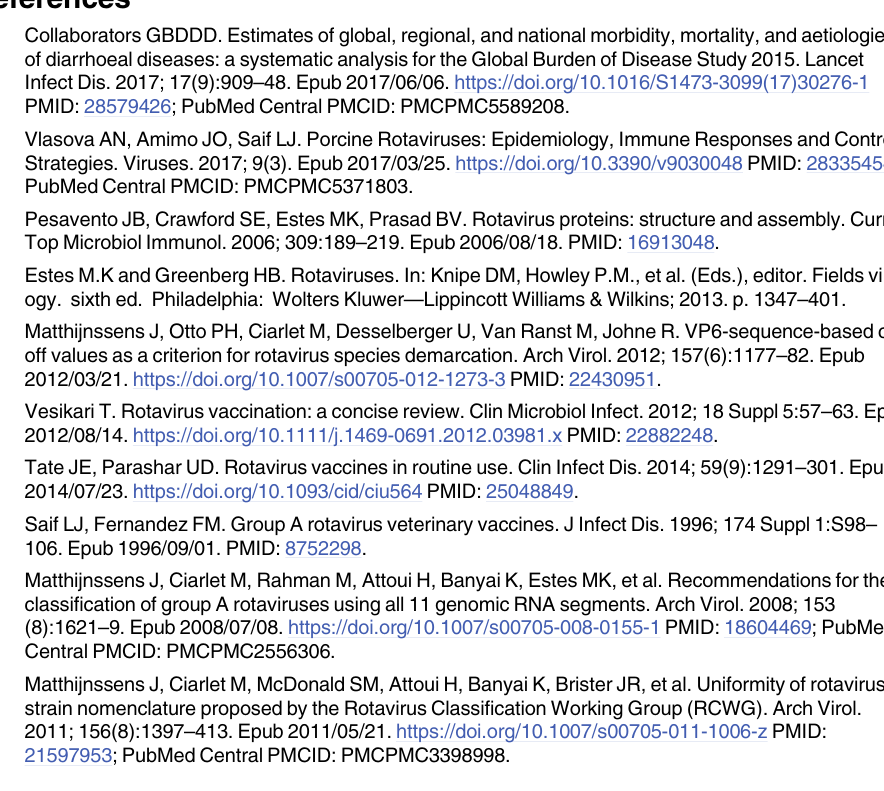
S1 Fig. Thailand map showing G/P genotype distributions of Thai porcine RVA strains in this